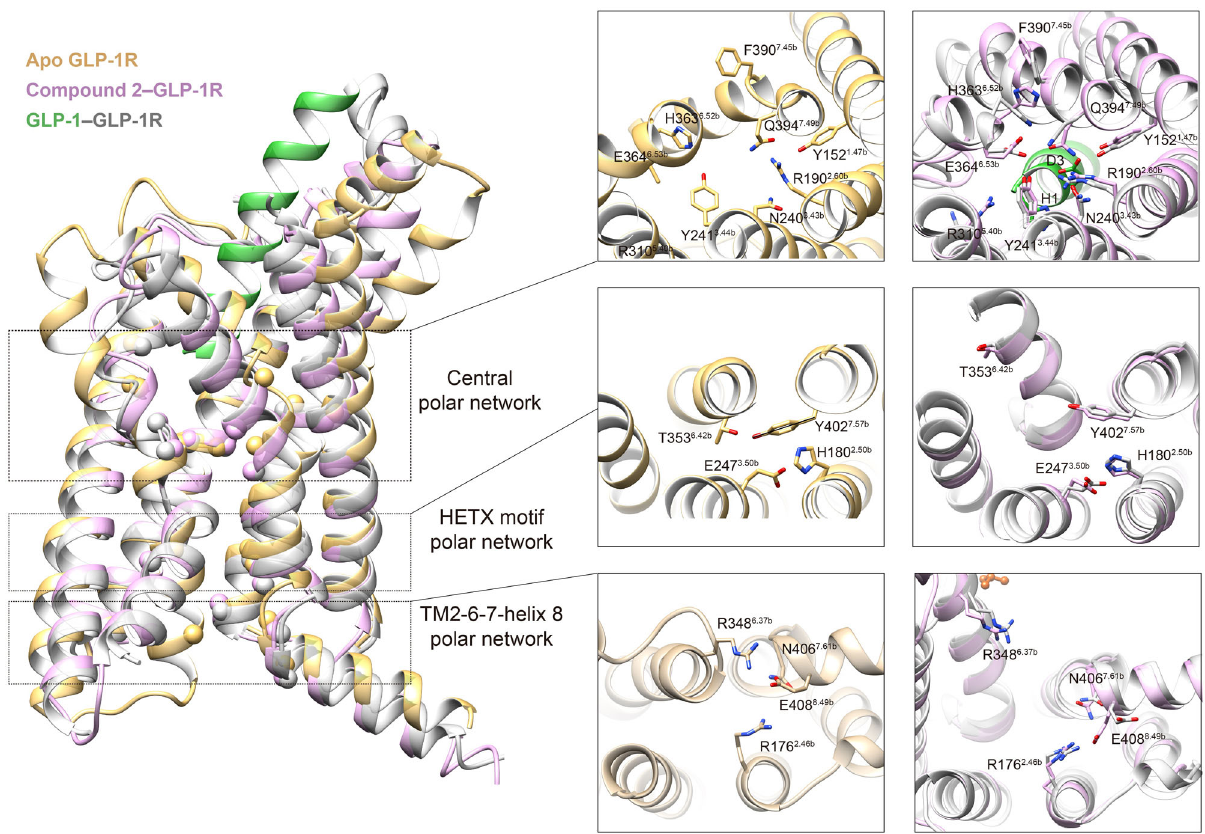
Fig. 4 Comparison of the polar network rearrangement upon GLP-1R activation triggered by compound 2 and GLP-1. Left, superimposition of compound 2 bound GLP-1R with the peptide-free apo state (PDB code: 6LN2) and GLP-1 bound active state (PDB code: 6X18). Upon receptor activation, three layers of the polar network (central polar network located on the bottom of the orthosteric binding pocket, family-wide conserved HTEX motif polar network, and TM2-6-7-helix 8 polar network that topologically close to G protein) were reorganized. The C α atoms of the residues that participated in the polar network rearrangements upon receptor activation are shown as spheres. Right, comparison of residual conformation between apo state, GLP-1-bound, and compound 2-bound active states for three layers of the polar network, whose residues are shown as a stick with Wootten numbering in